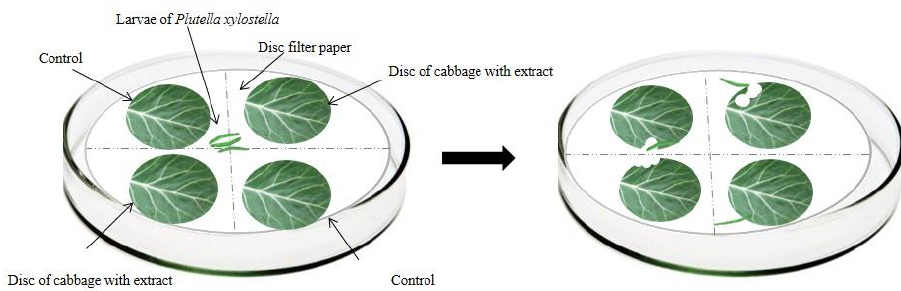
Figure 2. Schematic representation of the choice bioassay of antifeedant activity for Plutella xy- lostella larvae.